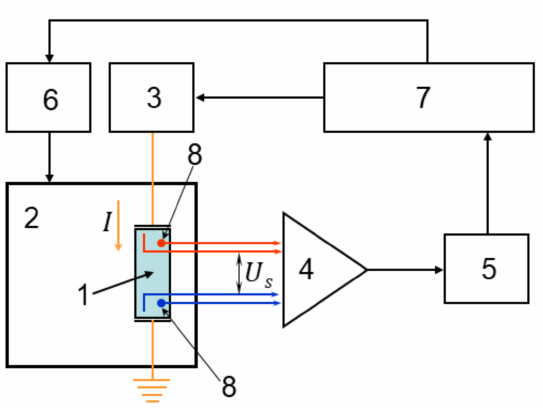
Figure 2. Block diagram of the automated system for the temperature-dependent Seebeck coefficient and electrical conductivity measurements. 1—sample, 2—cryostat, 3—current source, 4—switch card and amplifier, 5—analog-to-digital converter (ADC), 6—temperature controller, 7—computer, 8—temperature sensors.